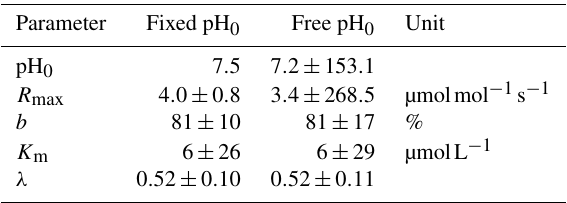
Table D3. Decomposition parameters for exponential pH